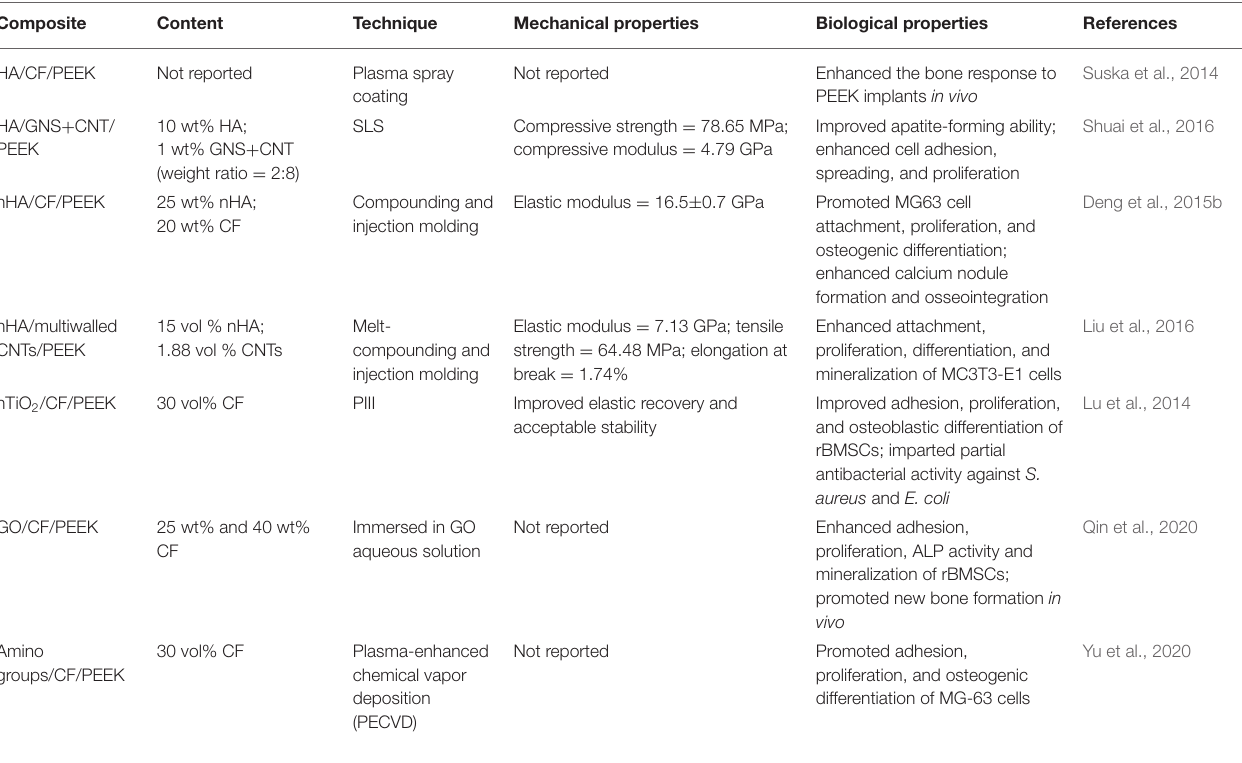
TABLE 1 | Mechanical and biological properties of carbon-based PEEK